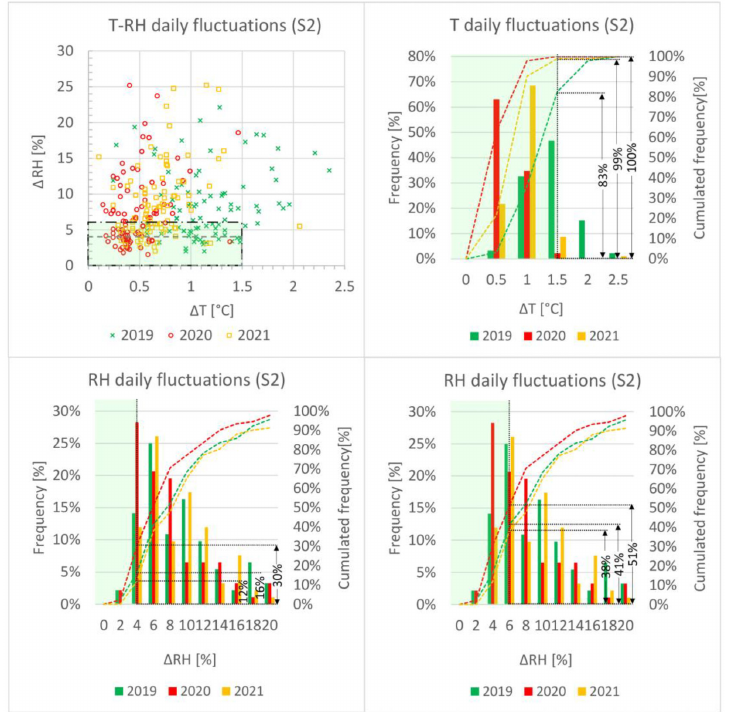
Figure A2. Scatterplot and frequency distribution comparison of indoor climate data (datalogger S2) from March to May 2019, 2020 and 2021 concerning the daily conservation range (the green area) proposed by